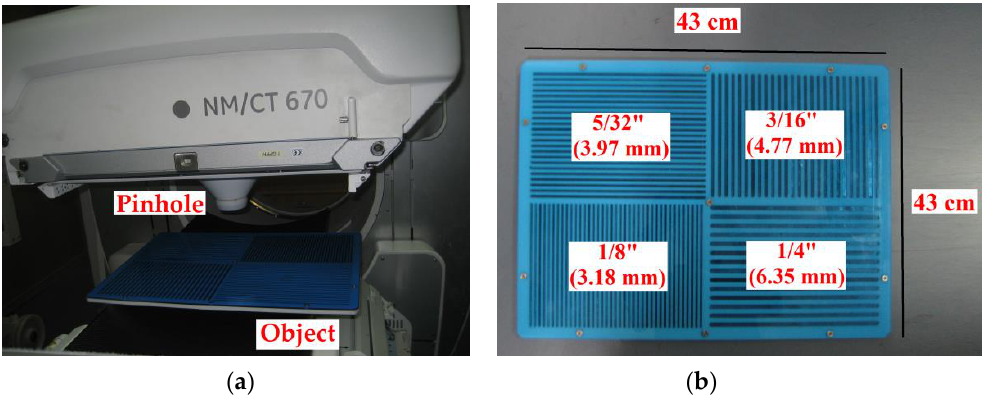
Figure 6. ( a ) The object (bar phantom lead plate) in the gamma radiation nuclear imaging SPECT system; ( b ) the bar phantom overall size: 16-7/8" × 16-7/8" (43 × 43 cm), bar widths: 1/4", 1/8", 3/16" and 5/32" (6.35, 3.18, 4.77, 3.97 mm).